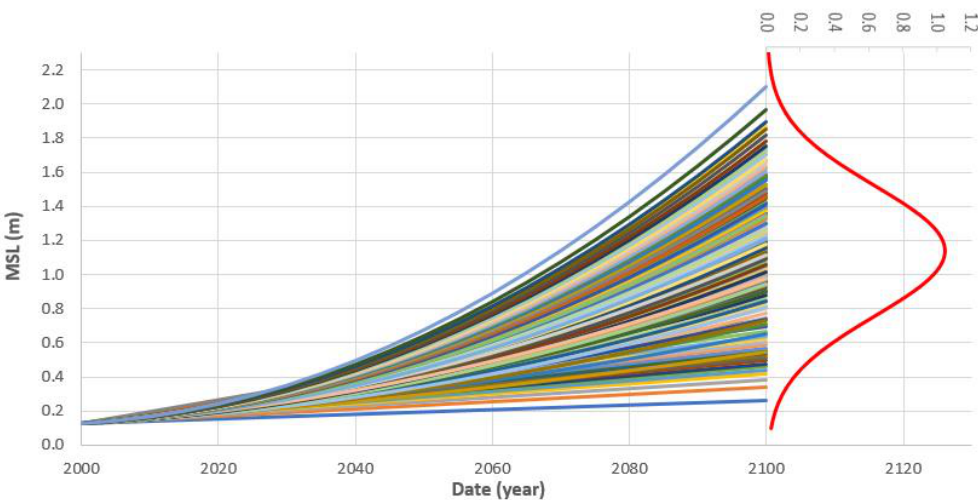
Figure 10. The ensemble of 147 relative SLR projections (in meters) for the 21st century of the WCPM, superimposed with PDF for 2100 (fitted to the MSL y -axis) and relative to the national vertical datum of Cascais 1938 (13 cm at epoch 2000).